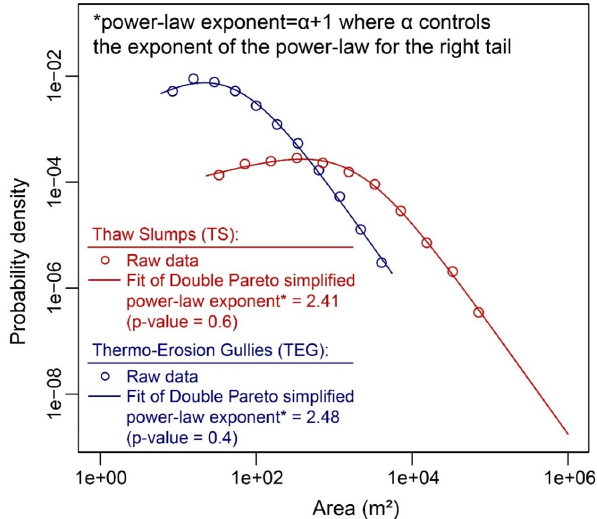
Figure 3. The FAD obtained for the two inventories in Norden- skiöld